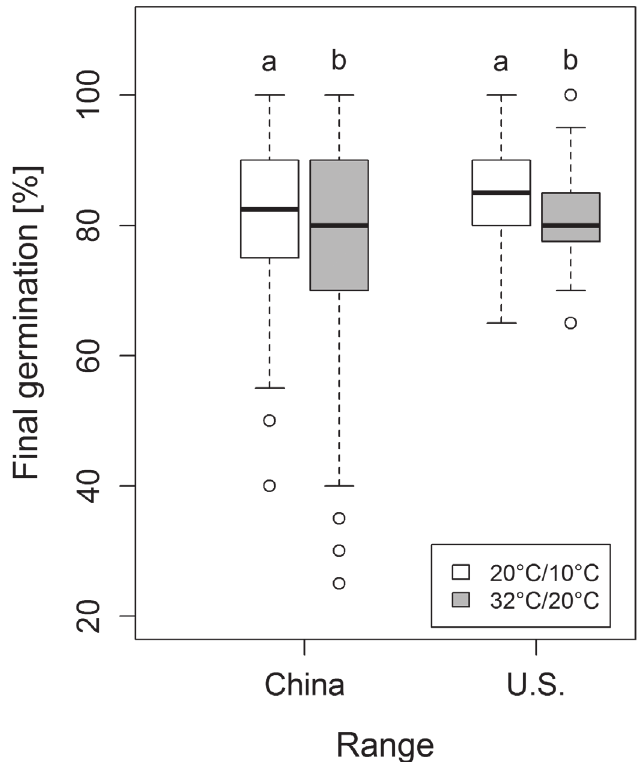
Figure 2. Final germination (%) of Ulmus pumila seeds from native and the non-native ranges. No dif- ferences were found between the two ranges ( F cantly decreased under warmer temperature treatment ( F shown by different letters above the